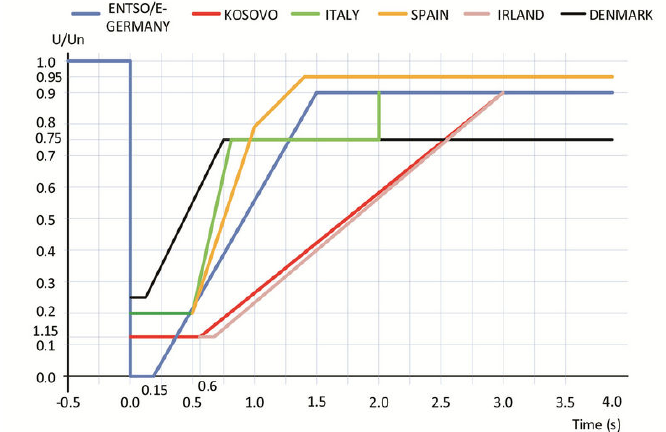
Figure 32. Summary of the fault ride through requirements in wind energy for different countries [152]. Kindly provided by Gazmend